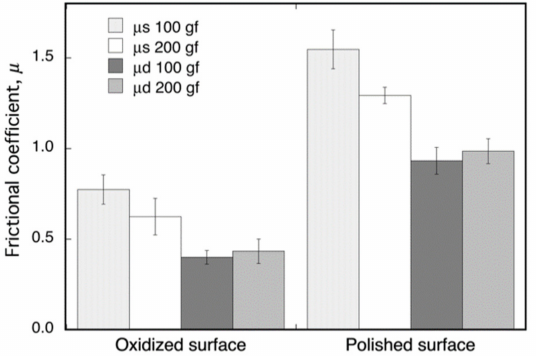
Figure 6. Dynamic ( µ d ) and static ( µ s ) frictional coefficients of oxidized and non-oxidized Ti–29Nb– 13Ta–4.6Zr. The oxidation conditions at 1273 K for 1.8 ks in